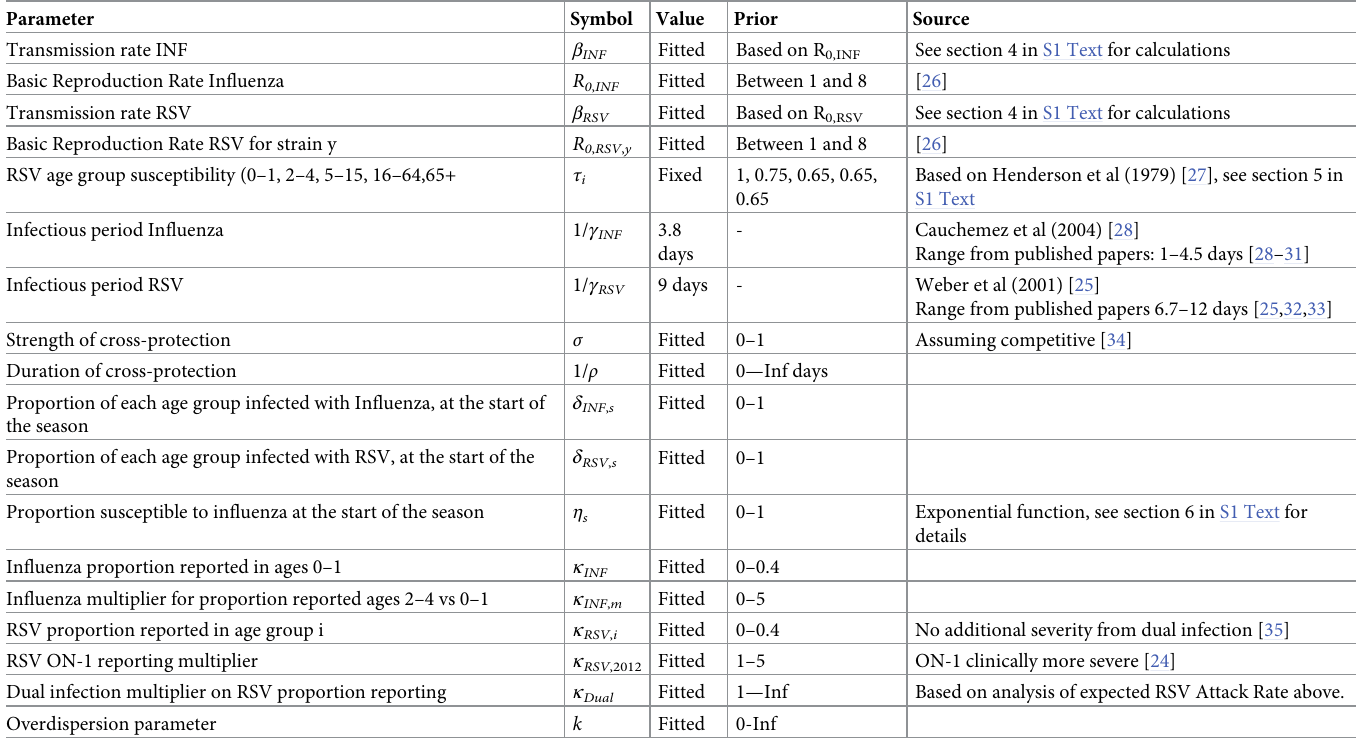
Table 1. Parameter definitions, values and